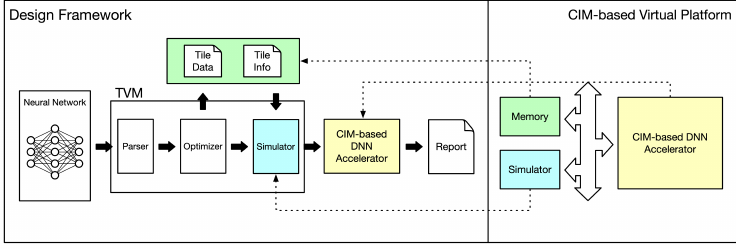
Figure 9. XBar architecture and ReRAM array model.